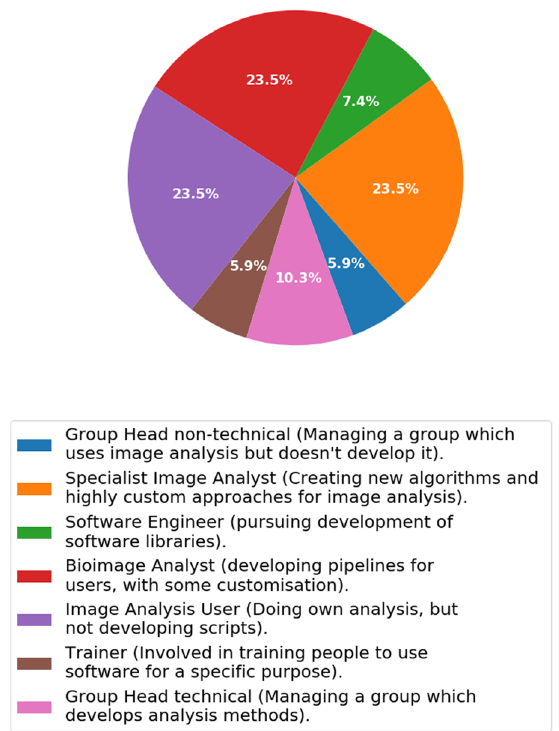
Figure 8. Answers from Q2.4 pooled amongst research group associated staff (e.g. Principal Investigator, Research Assistant in a research group, Research Software Engineer in a research group, PhD, Post-doc in a Research Group). Participants were able to check multiple